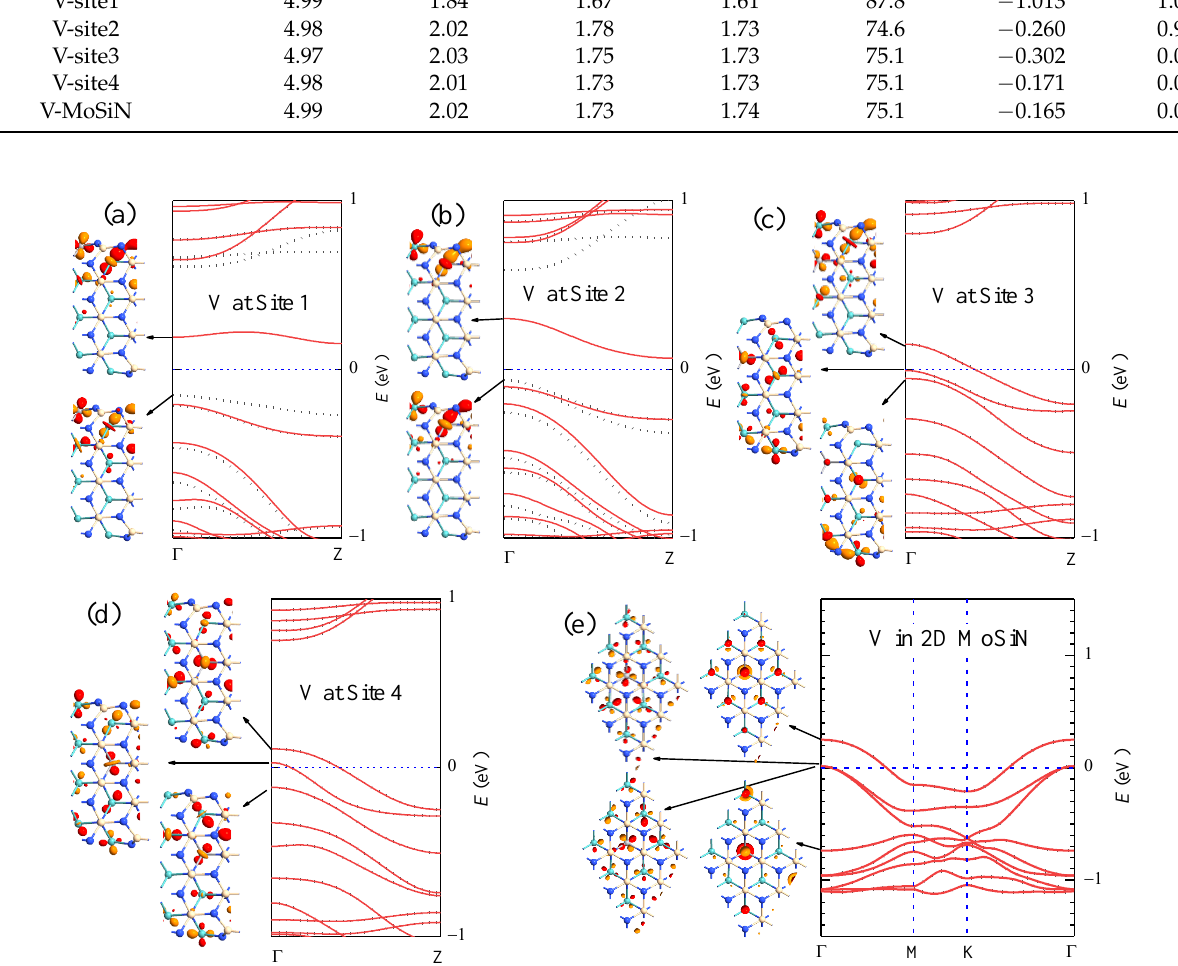
Figure 6. Band structure of aMoSiNNR doped by V atoms at ( a ) site 1, ( b ) site 2, ( c ) site 3, and ( d ) site 4. The band structure of the 2D MoSiN doped by one V atom in each 3 × 3 supercell is shown in ( e ). The Γ point wave functions of states in some bands near the Fermi level are plotted as insets.